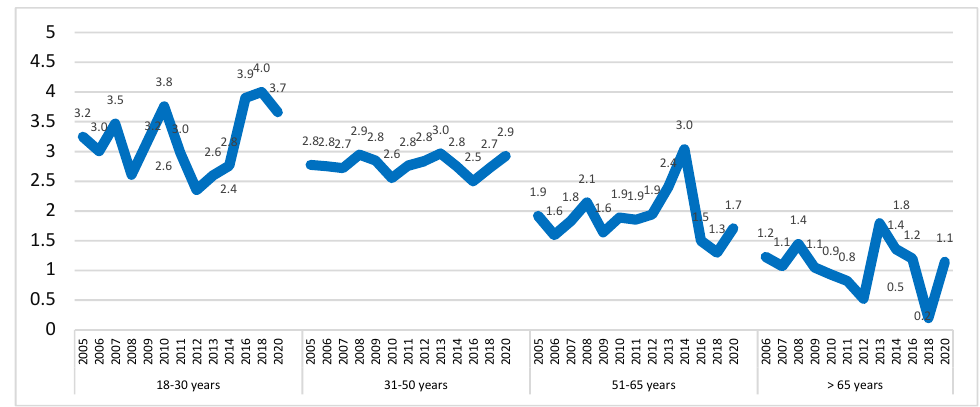
Figure 16. The General Diversity Index based on three weighted positive and three weighted negative statements about diversity—according to level of education.